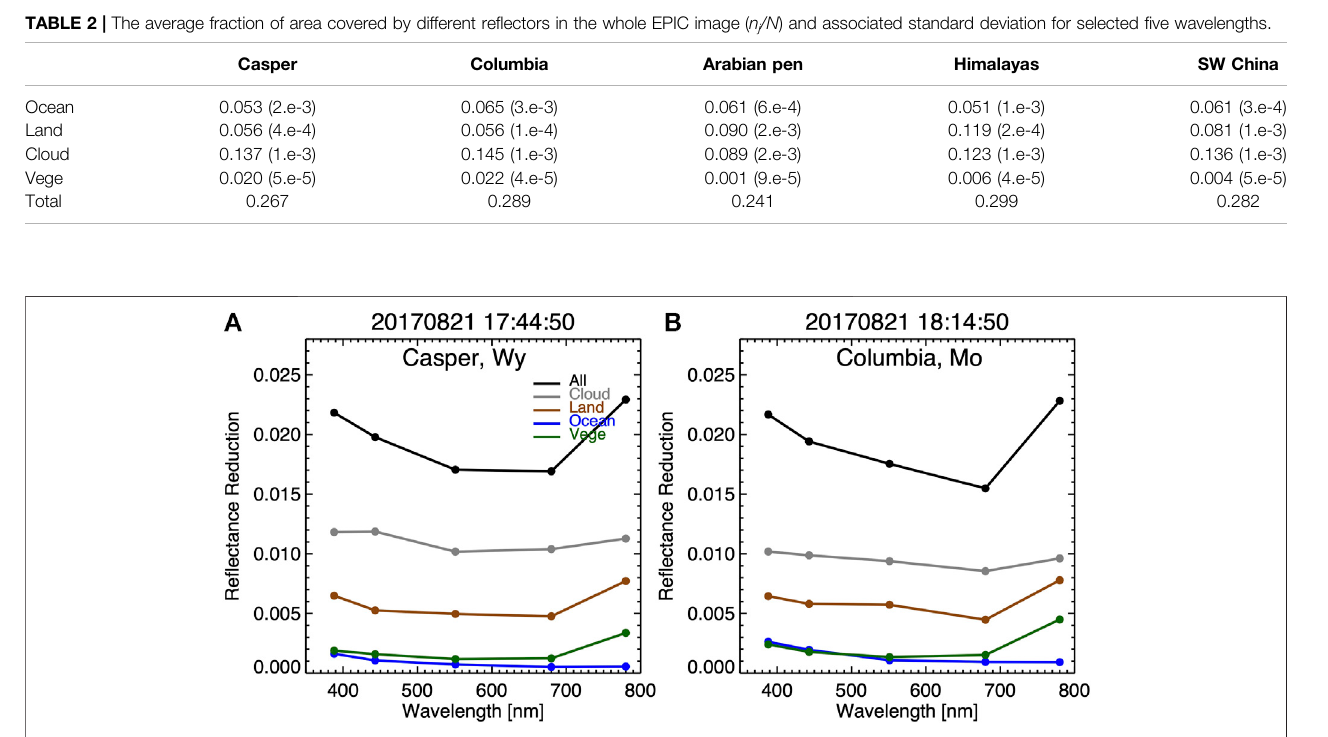
FIGURE 9 | Similar to Figure 7 but the two cases during the 2017 solar eclipse.